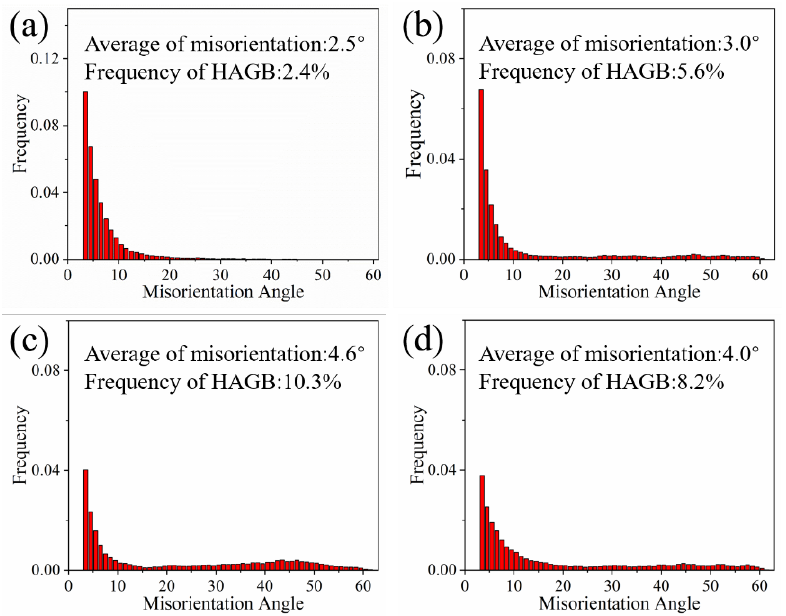
Figure 6. Distribution of misorientation angles of the alloys ( a ) AL1; ( b ) AL2; ( c ) AL3; ( d ) AL4. Figure 7 illustrates the TEM images of AL1 and AL2 alloys after the rolling process.